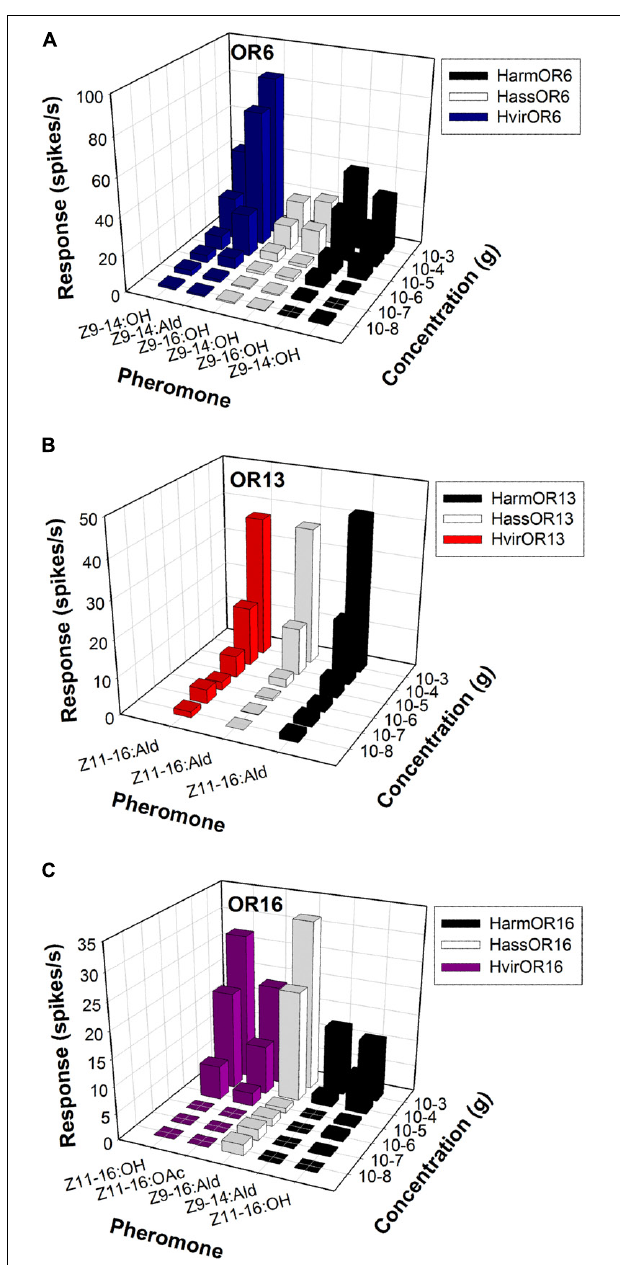
FIGURE 4 | Odor coding of pheromone receptors from three closely related species across concentrations. (A) Dose-responses of OR6-expressing neurons in at1 sensilla of transgenic flies. (B) Dose-responses of OR13-expressing neurons in at1 sensilla of transgenic flies. (C) Dose-responses of OR16-expressing neurons in at1 sensilla of transgenic flies.